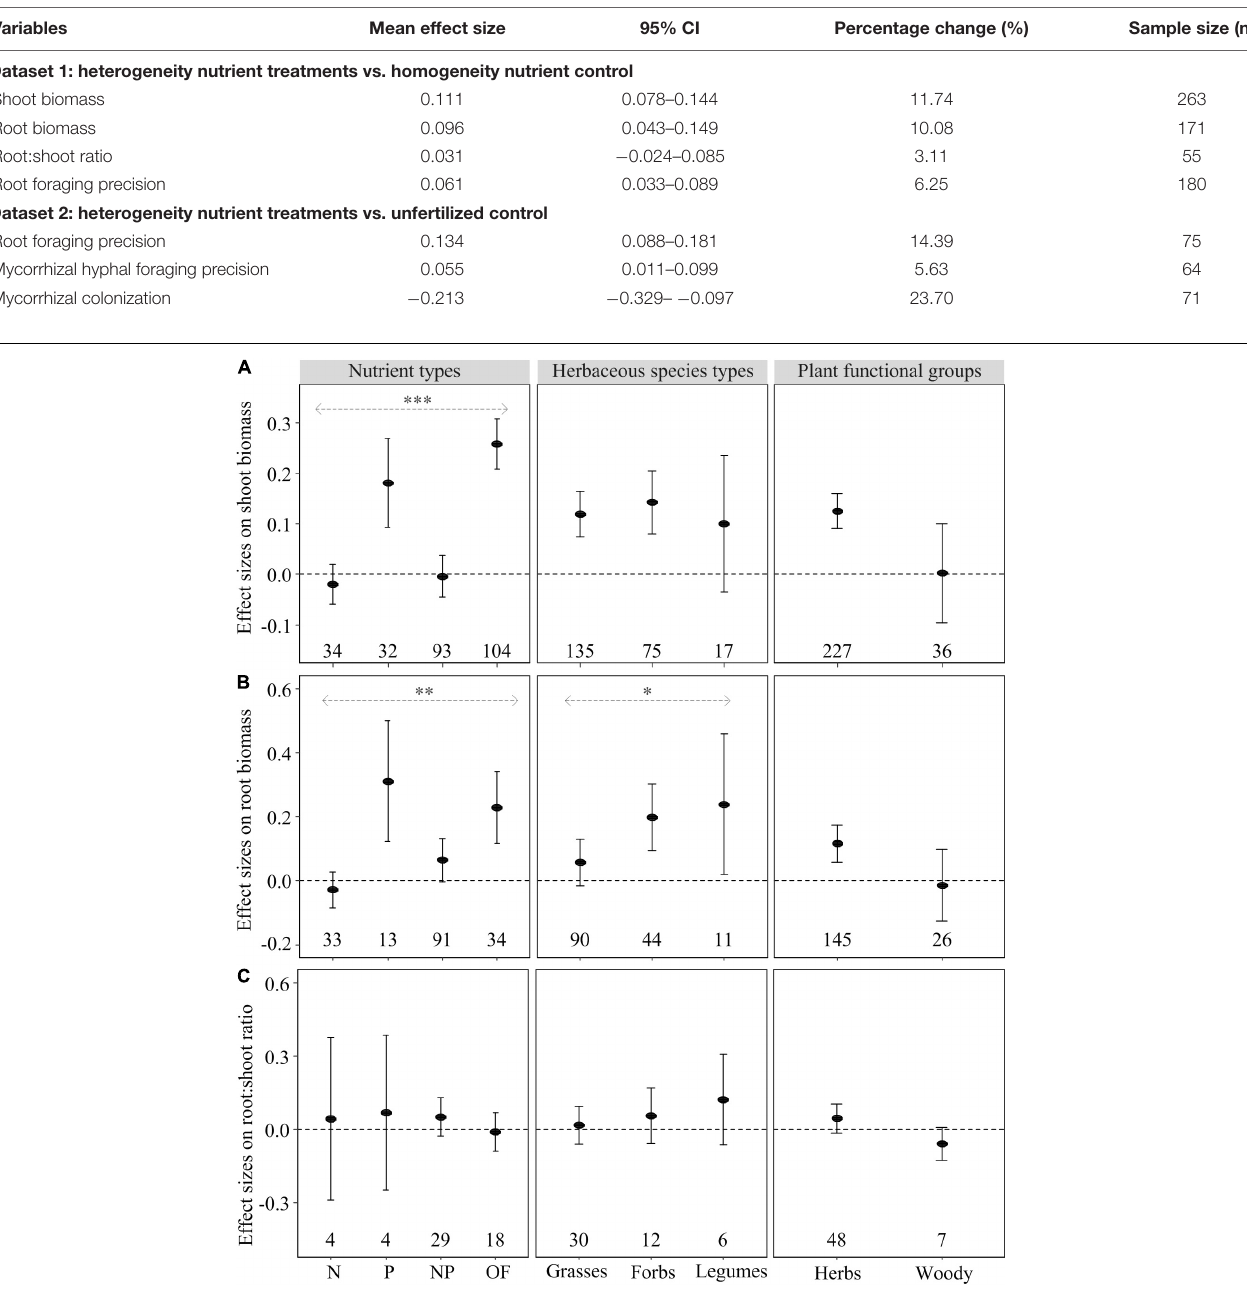
TABLE 1 | The statistics for the responses of plant and mycorrhizal fungi traits to nutritionally heterogeneous environments. Variables